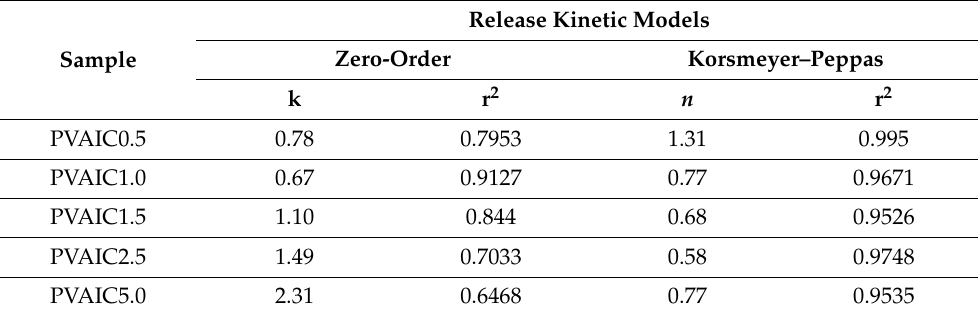
Table 3. Modeling results of quercetin released from PVA hydrogels loaded with quercetin/HP- β -CD inclusion complex fitting with Zero-order and Korsmeyer–Peppas models.